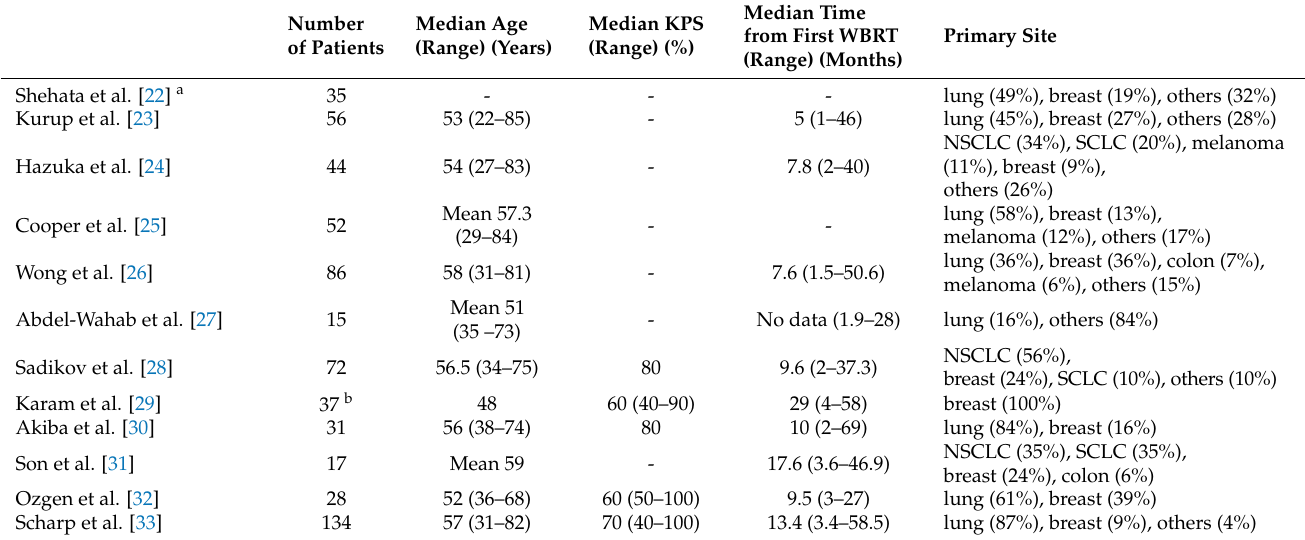
Table 1. The characteristics of re-whole brain